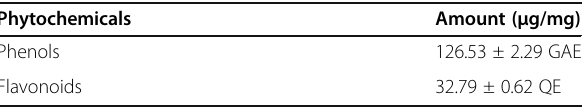
Table 2 Estimation of phenols and flavonoids from root extract of S.